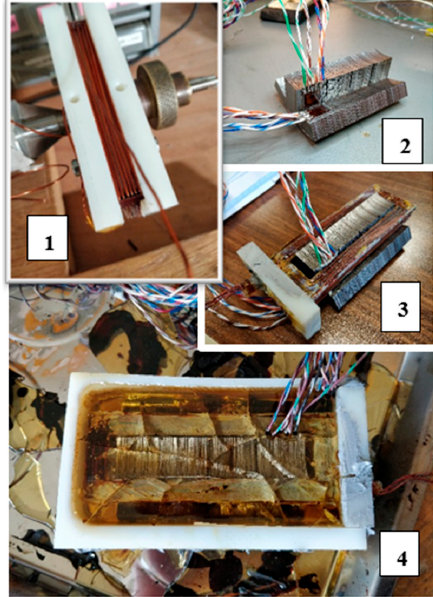
Figure 16. Construction of the segmented stator winding set-up: ( 1 ) 0.9 mm copper wire is wounded, having 36 turns spaced equally; ( 2 ) two strain gauges are installed on the stator segment, one beneath the yoke and one along the side of the tooth; ( 3 ) the epoxy impregnated winding is placed around the tooth; ( 4 ) the remaining space around the winding is also impregnated with epoxy.